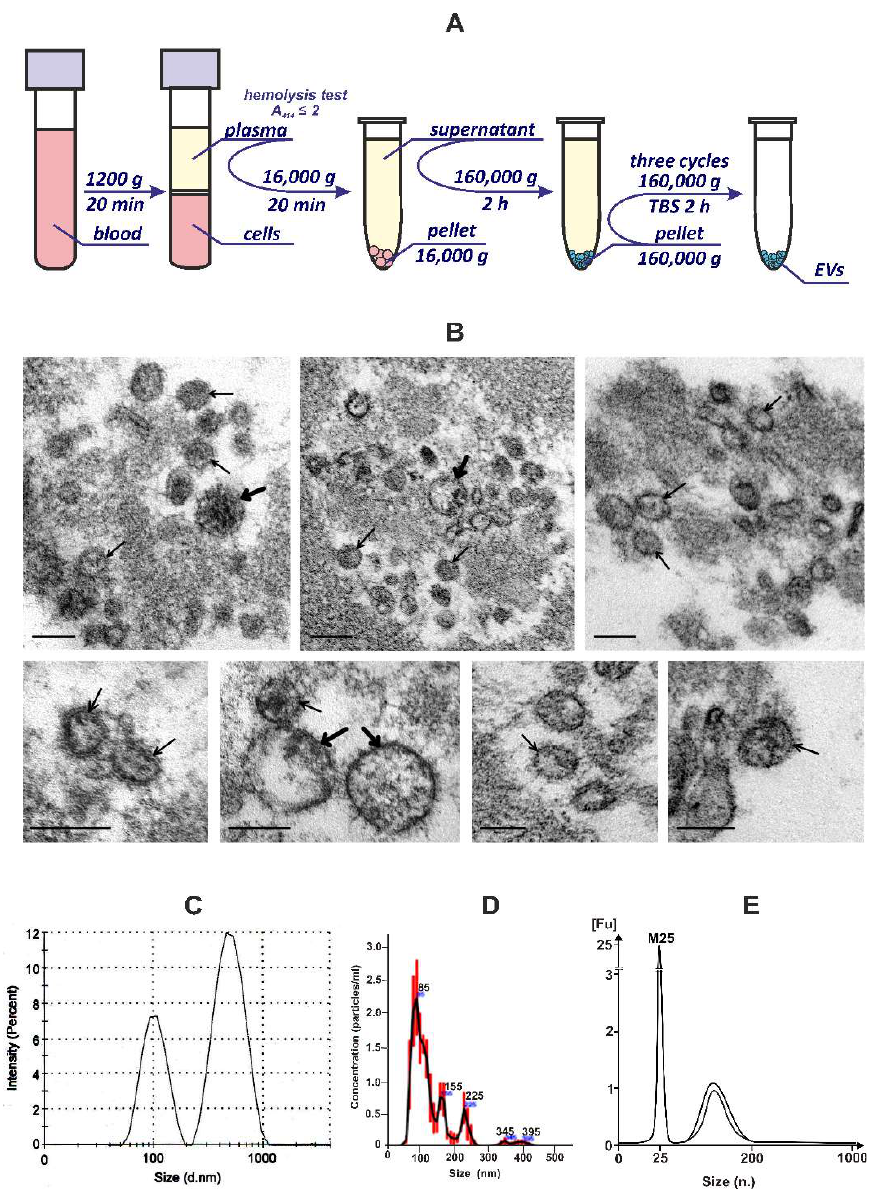
Figure 1. Human blood extracellular vesicle preparations. ( A ) Isolation and purification of extracellular vesicles from the blood of healthy donors. ( B ) Vesicles visualized by TEM in ultrathin sections of pellets (160,000× g ultracentrifugation). The upper row shows accumulations of vesicles, the lower row shows enlarged images of the vesicles. Thin arrows show vesicles with size and morphology corresponding to exosomes, and thick arrows, to microvesicles. Scale bars correspond to 100 nm. ( C , D ) The size distribution of extracellular vesicles was determined using dynamic light scattering and nanoparticle tracking analysis. ( E ) RNA length distribution of extracellular vesicles analyzed using Agilent Bioanalyzer 2100 on an RNA 6000 Pico chip; the RNA length marker (M25); n.—nu- cleotide.